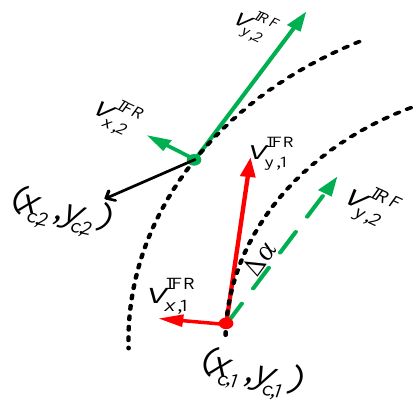
Figure 10. Rotation angle of the center of mass (COM) coordinate